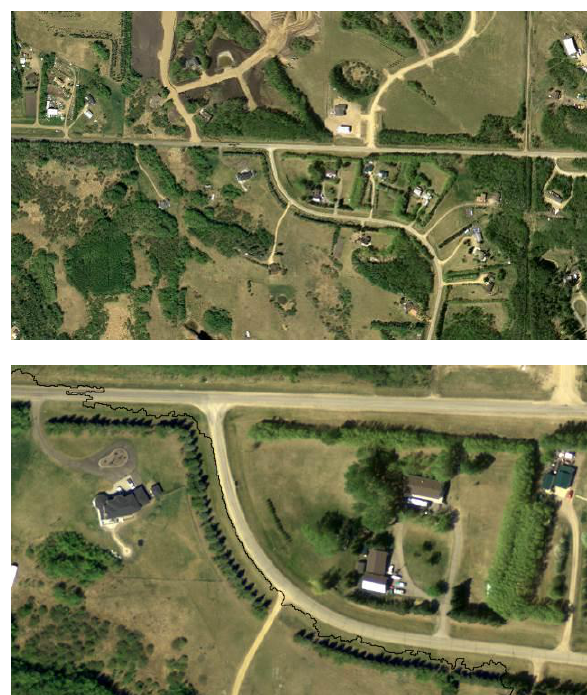
Figure 15. An example of a seamline following a curved road